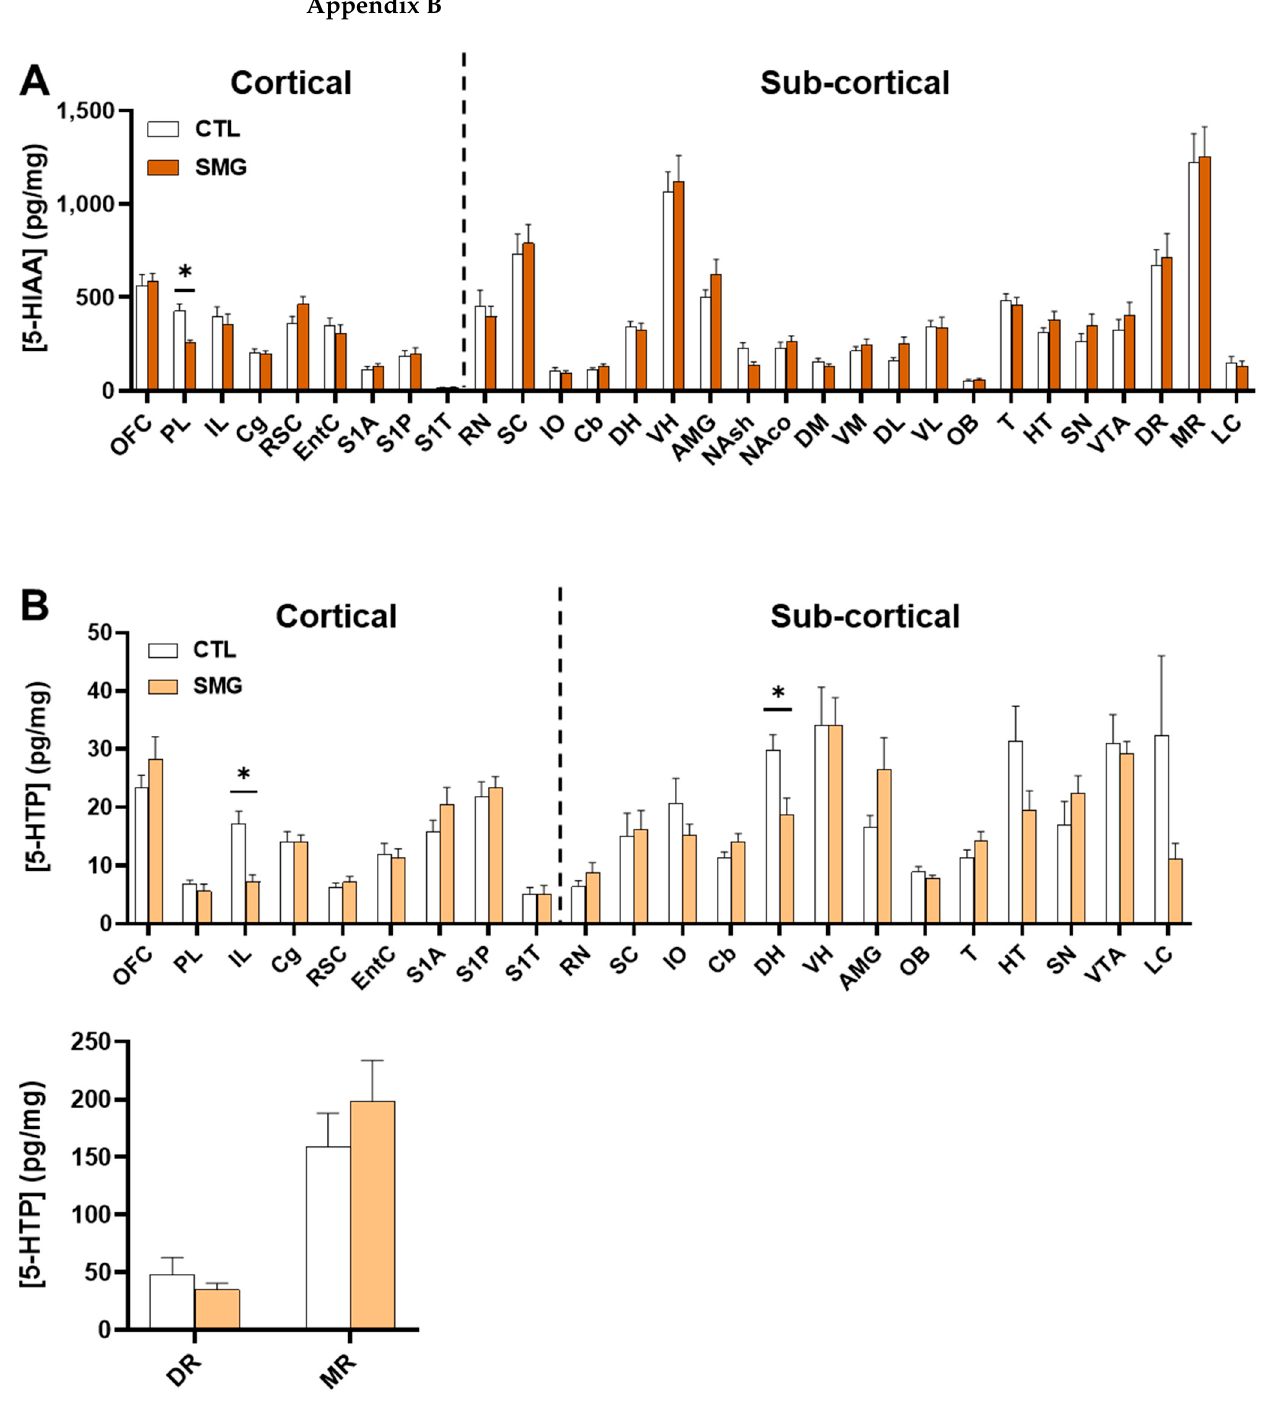
Figure A2. Effect of SMG on 5-HIAA ( A ) and 5-HTP ( B ) content in the brain. All data are presented as mean ± sem ( n = 12 rats/group). * p < 0.05, significant difference between the SMG and CTL groups (Mann–Whitney test).